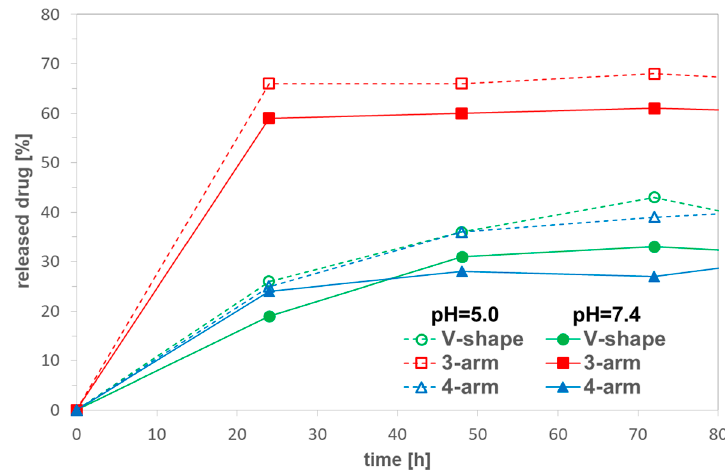
Figure 3. DOX release profiles from conjugates of star-shaped copolymers with equimolar compositions and various number of arms, DGL2.1 (V-shaped), DGL2.2 (3-armed), and DGL2.3 (4-armed) in PBS at 37 °C.